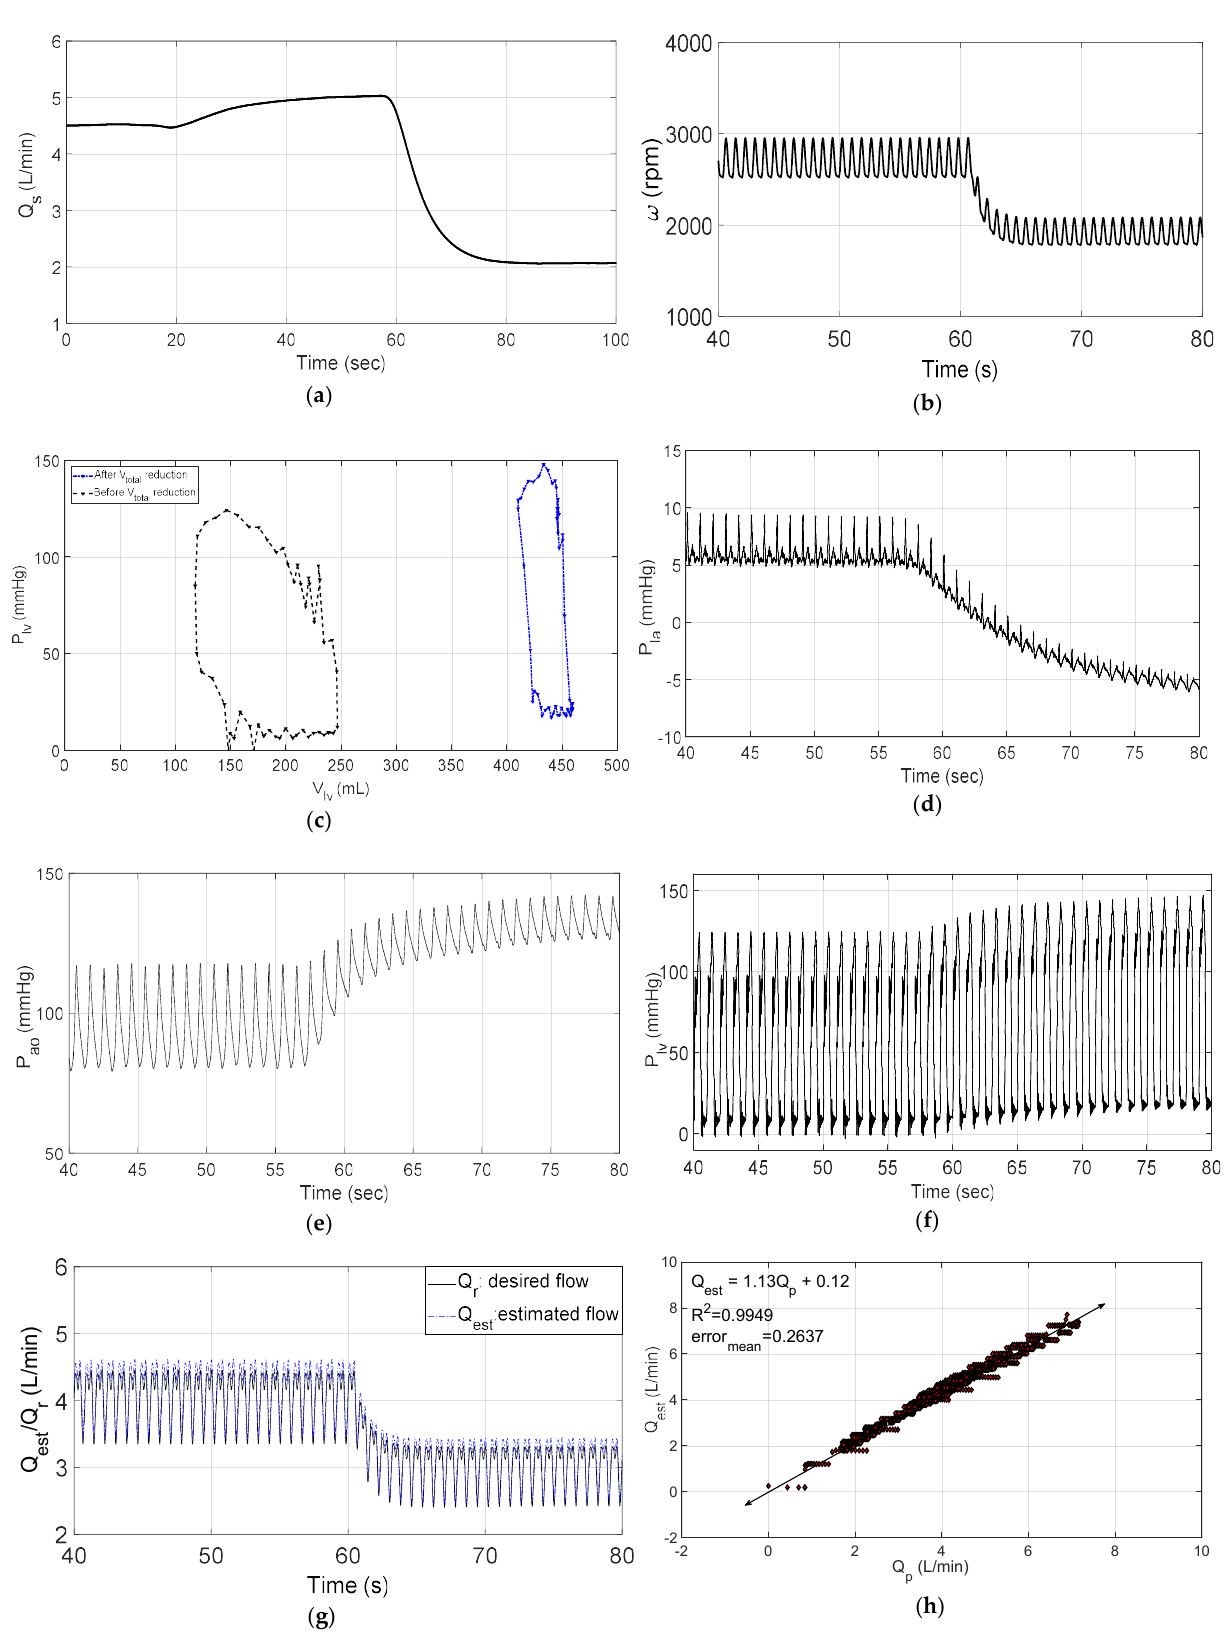
Figure 6. Results in relaxation test; ( a ) systematic flow ( Q s ); ( b ) IRBP speed ( ω ( t ) ); ( c ) stroke volume (SV); ( d ) left atrium pressure ( 𝑃 (cid:3039)(cid:3028) ); ( e ) aortic pressure ( 𝑃 (cid:3028)(cid:3042) ); ( f ) left ventricle pressure ( 𝑃 (cid:3039)(cid:3049) ); ( g ) esti- mated flow ( 𝑄 (cid:3552) (cid:3032)(cid:3046)(cid:3047) ) vs. desired reference flow ( 𝑄 (cid:3045) ); ( h ) correlation between estimated flow ( 𝑄 (cid:3552) (cid:3032)(cid:3046)(cid:3047) ) and actual flow ( 𝑄 (cid:3043) ).